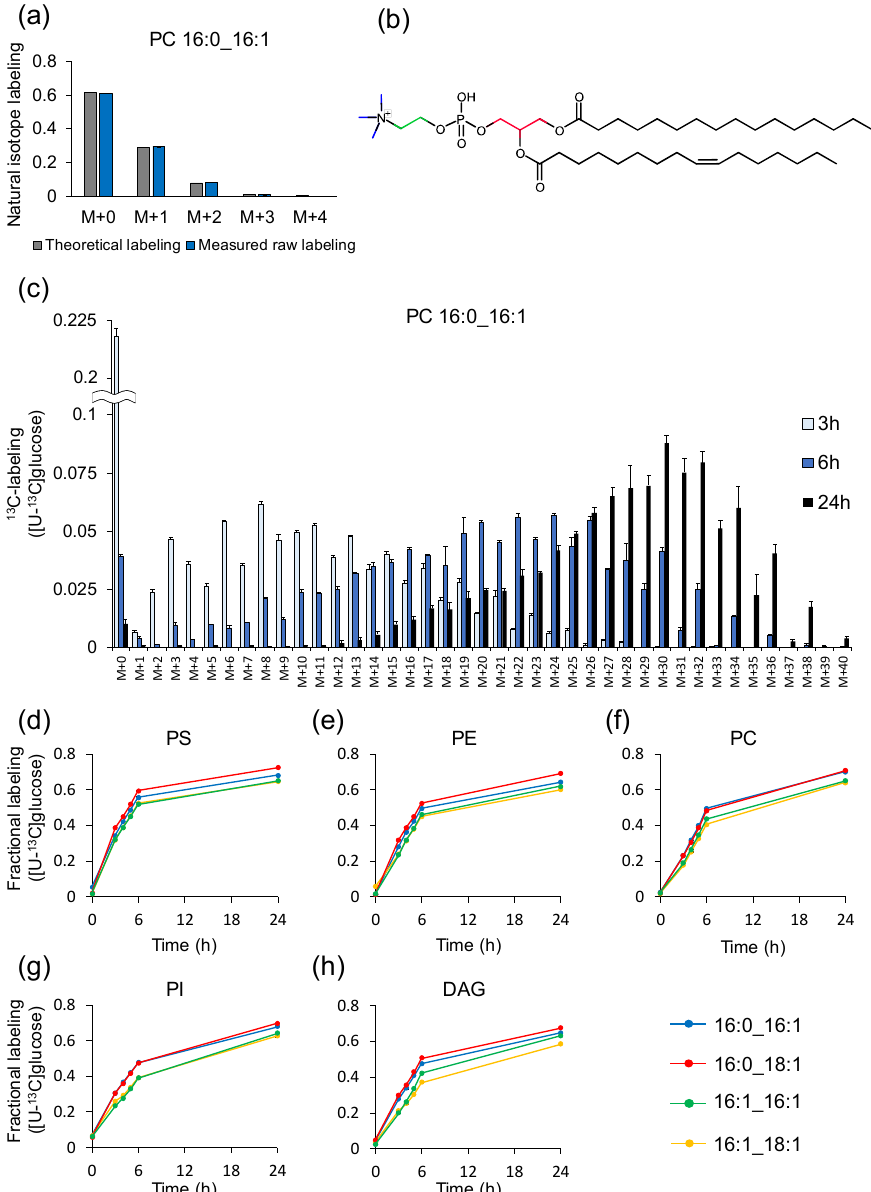
Figure 4. 13 C-labeling of glycerolipids in S. cerevisiae BY4947. ( a ) Theoretical and measured raw labeling of PC 16:0_16:1 obtained from S. cerevisiae cells cultured in unlabeled medium. ( b )